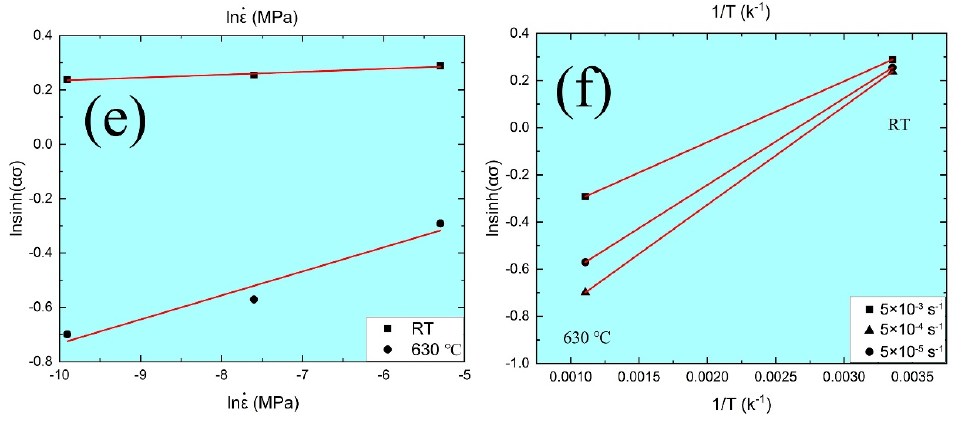
. . ε ; ( b ) ln σ − 1/ T ; ( c ) σ − ln ε ;